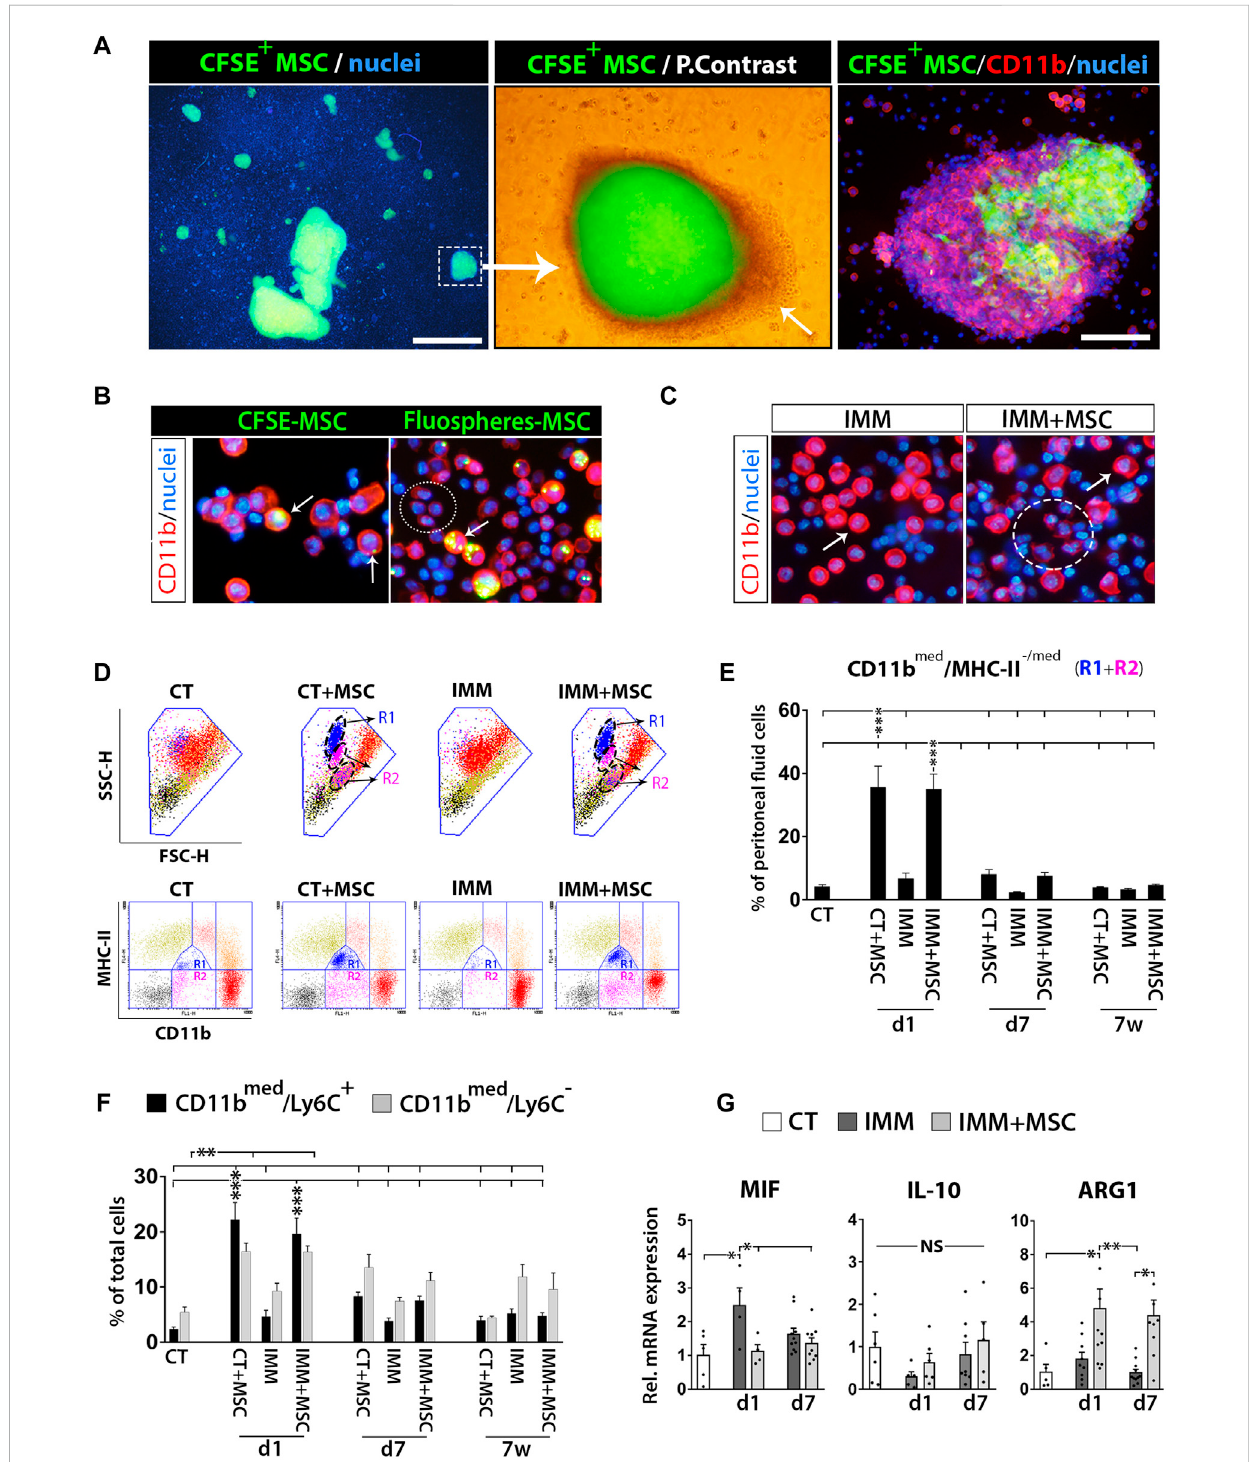
Intraperitoneally transplanted UC-MSC are targeted by peritoneal macrophages in a process accompanied by a strong mobilization of neutrophils and myeloid-derived suppressor cells in the peritoneal fl uid. (A) Left image, shows low 2X magni fi cation fl uorescence picture of a peritoneal drainage collectedat24 hpost-transplantationofCFSE + UC-MSCandshowingpresenceofmanysmalltoverylargeCFSE + UC-MSCclusters.Scalebaris500 µm. Middle image, merged fl uorescent and light photograph of CFSE + UC-MSC aggregates showing a core of CFSE + UC-MSC surrounded by several layers of CSFE neg external cells (arrow). Right image, CD11b-PE staining of peritoneal lavage cells helpedto visualize how CFSE + UC-MSC aggregates had an external layer of CD11b high /CSFE neg peritoneal macrophages. Scale bar is 100 µm. (B) Shows CD11b-PE stained peritoneal fl uidcells (PFC) collected by from IMM-RIP-B7.1 mice at 24 h post-transplantation of CSFE + UC-MSC, or UC-MSC bearing phagocytosed Fluospheres. Note how, UC-MSC-derived fl uorescent residues are by majority internalized into large CD11b high peritoneal macrophages (arrows) but not into small CD11b low expressing myeloid cells (ellipse). (C) CD11b-PE staining of PFC collected at 24 h from immunized mice transplanted with vehicle (IMM) or UC-MSC (IMM + MSC). Note the